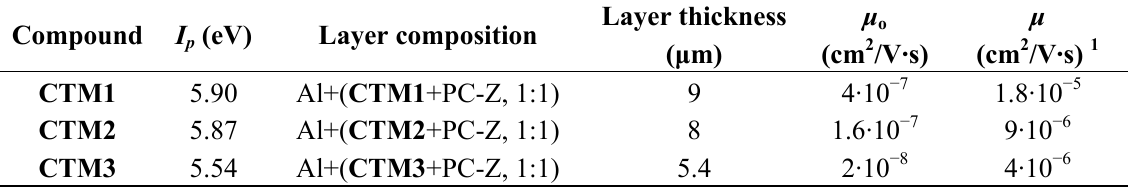
Table 2. I and hole drift mobility data for mixtures of 2 and CTM1 – 3 with p